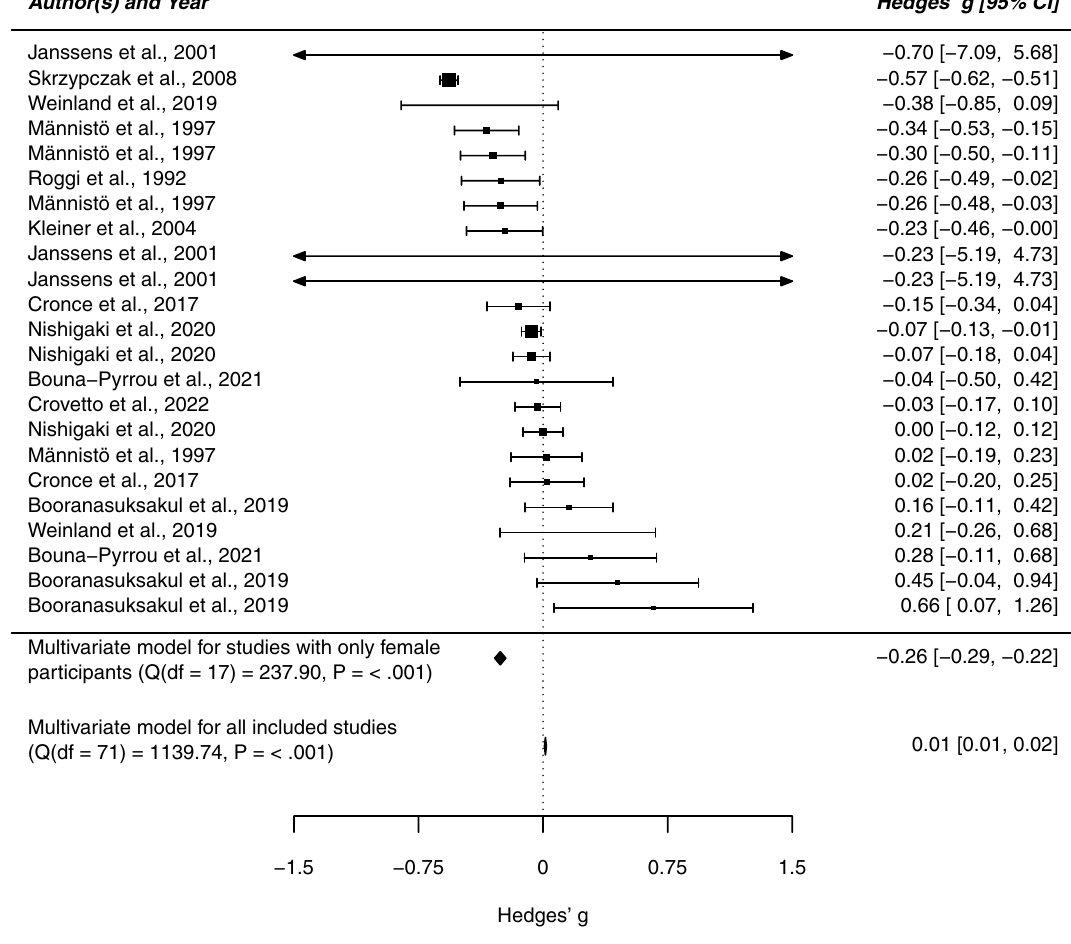
Figure 3. Forest plot of the standardized mean difference in BMI among female drinking and non-drinking subjects. This plot shows the results of the individual studies examining females together with their 95% confidence interval (CI). The weight of each study contributing to the overall effect is illustrated by the size of the square. The summary polygons at the bottom of the plot show the results from the multivariate meta- analytic model for (1) the subgroup of females and for (2) all included